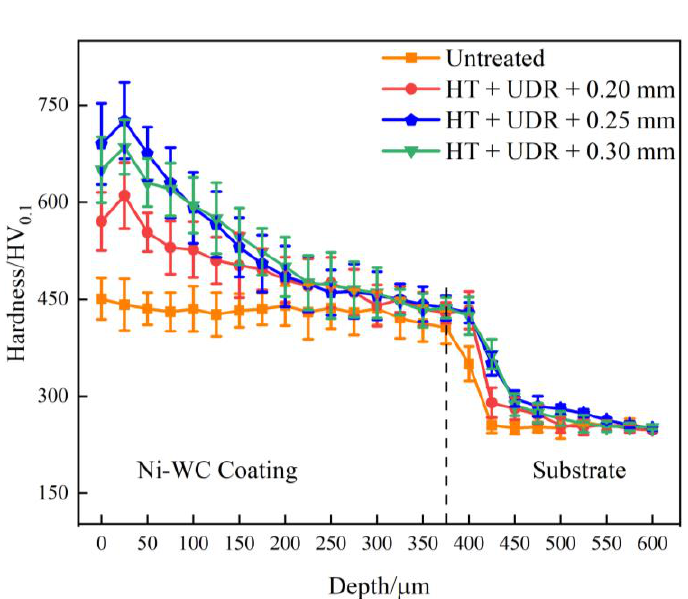
Figure 8. Distribution of hardness along with depth under different preloading depths.